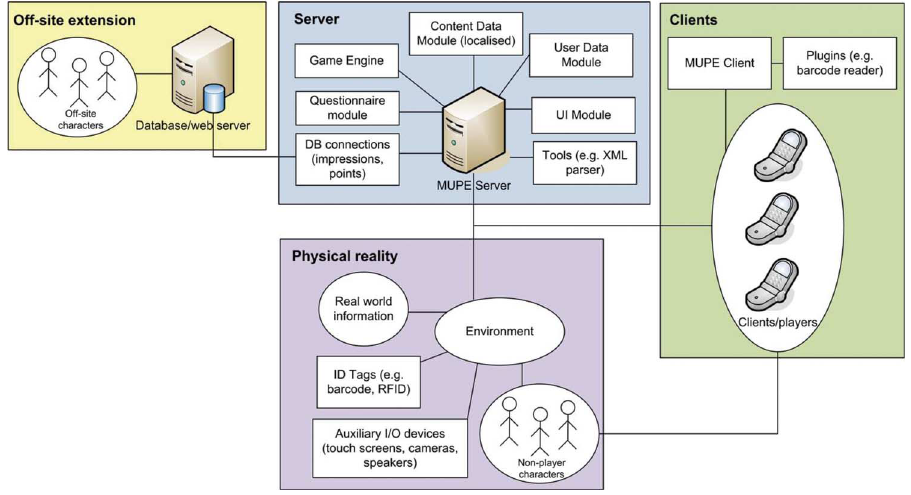
Figure 4. High-level architecture of the Myst